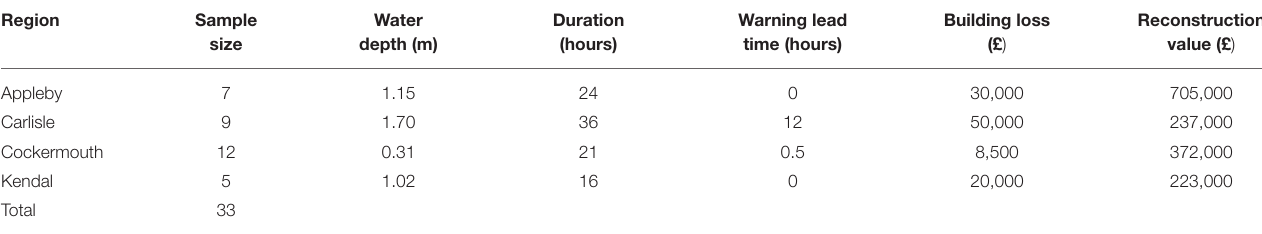
TABLE 1 | Summary of empirical data: sample size of complete records; medians of water depth in meters, duration in hours, warning lead time in hours, absolute building loss in £, and reconstruction value in £.